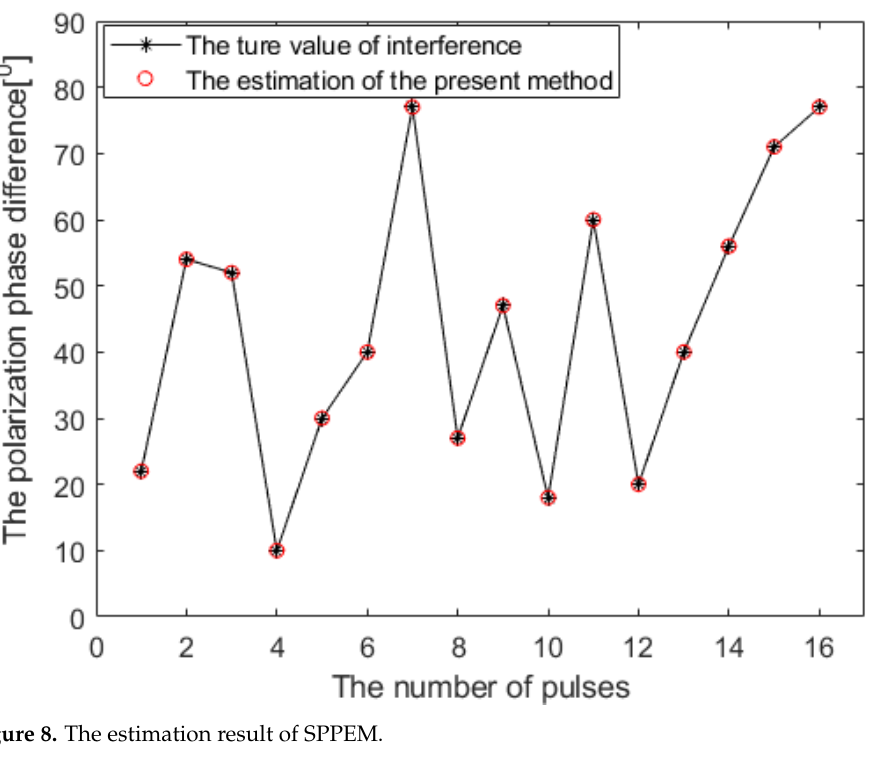
Figure 8. The estimation result of SPPEM.